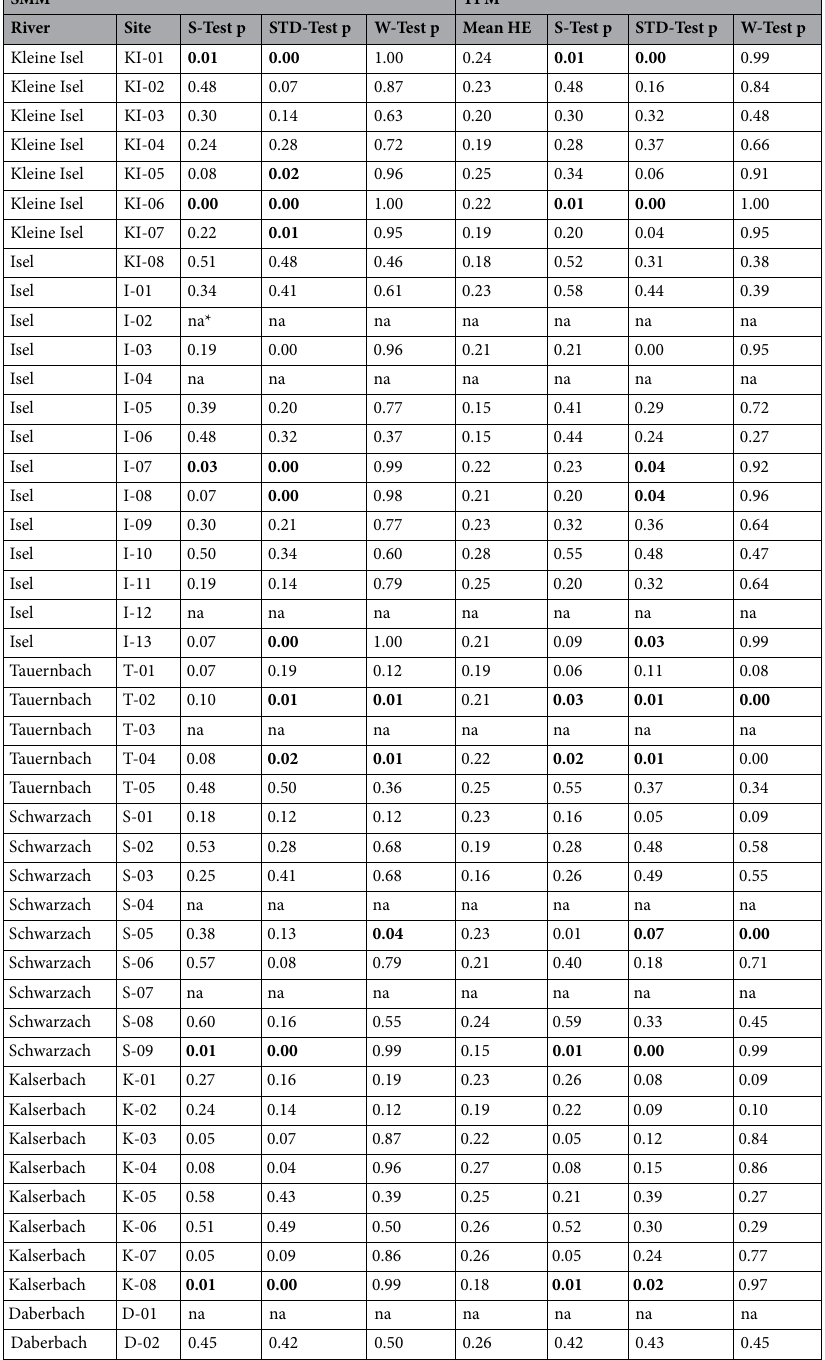
Table 2. Results of test for bottleneck using assumptions of the stepwise mutation model (SMM) and a two-phase model (TPM, combination of 90% of SMM and 10% of IAM) for sites along Isel and its tributaries. p-values of sign test (S-Test), standardized difference test (STD-Test), and one-tailed Wilcoxon sign-rank test (W-Test) as well as the mean expected heterozygosity (mean HE) for der TPM model are given, with significant values (< 0.05) highlighted in bold. *na for sites with < 10